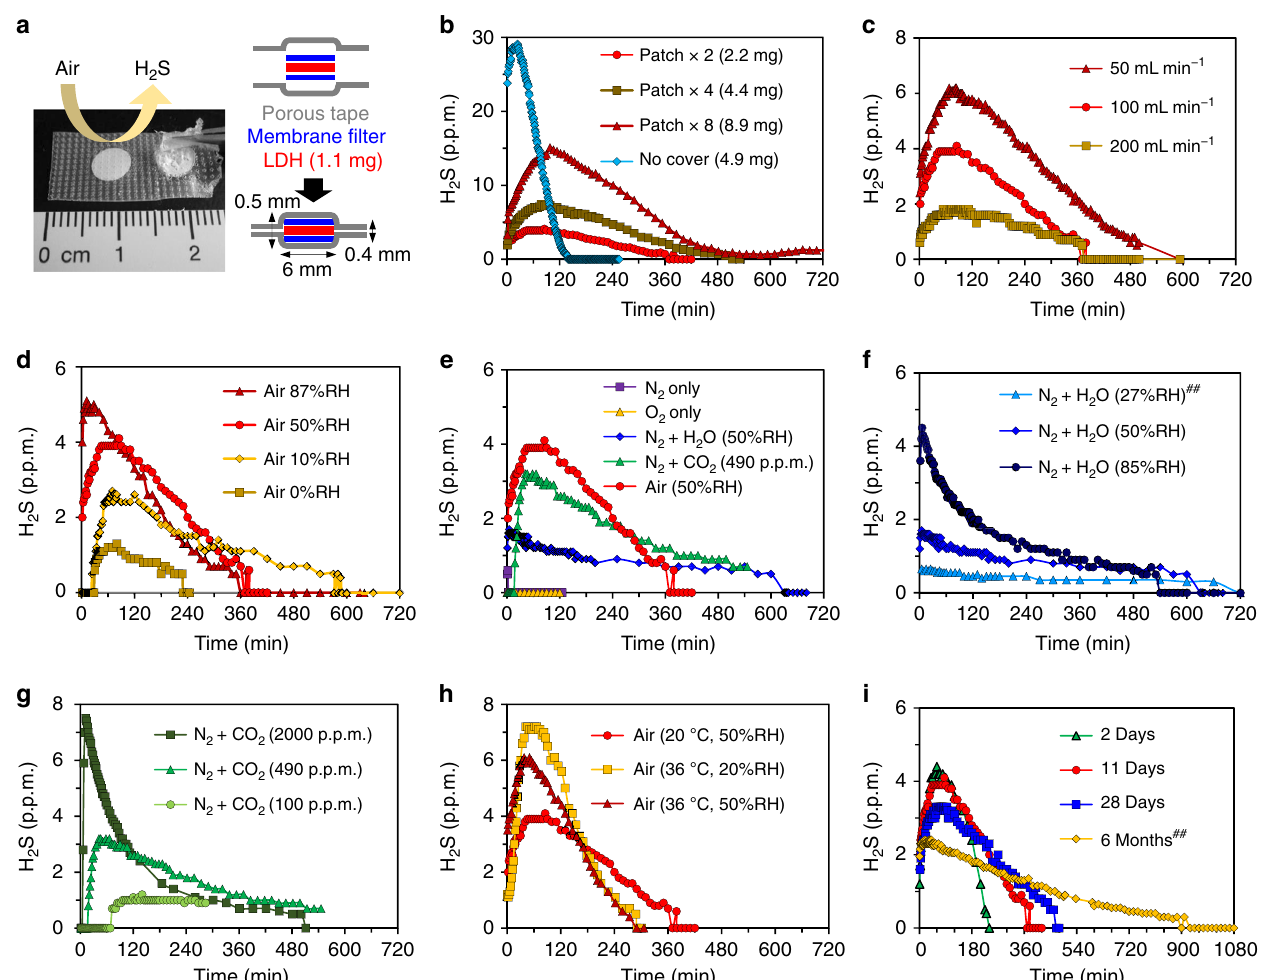
Fig. 3 H 2 S release pro fi les from NaHS-Mg/Al(2/1) sandwiched between porous tapes. a Photograph and illustration of H 2 S release patches. One